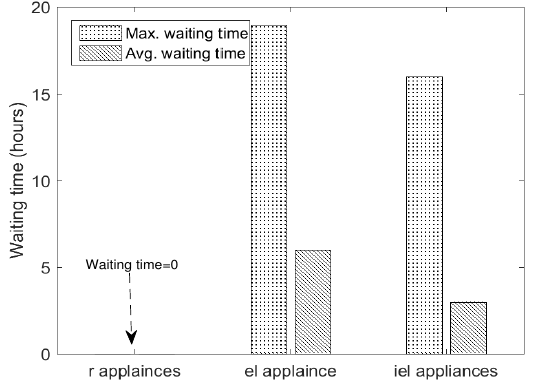
Figure 21. Average waiting time of r , el and iel appliances.